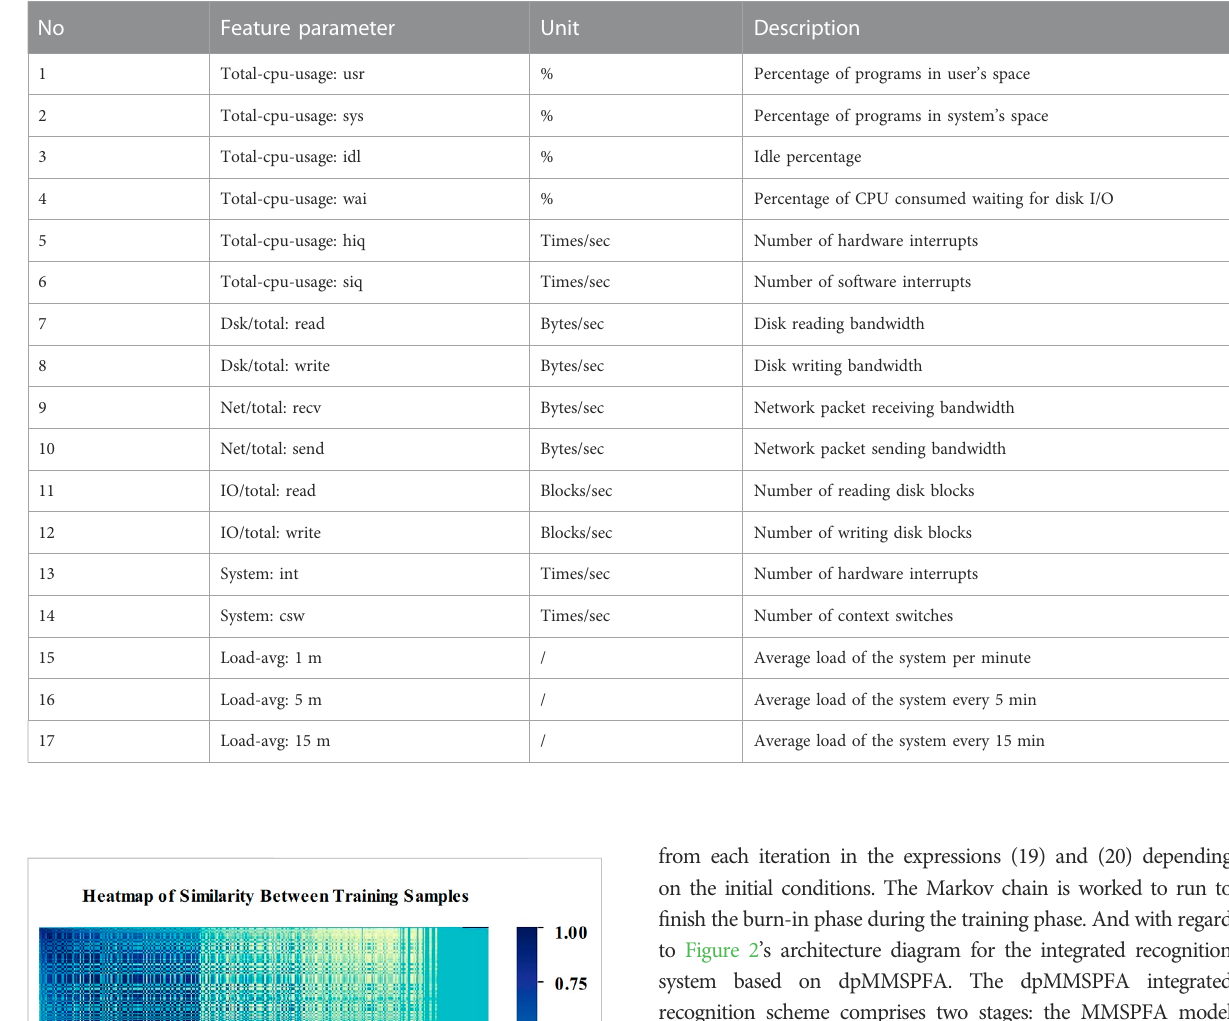
TABLE 6 Characteristic